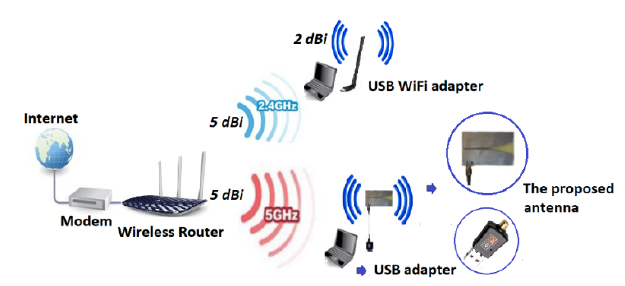
FIGURE 10. Test configuration